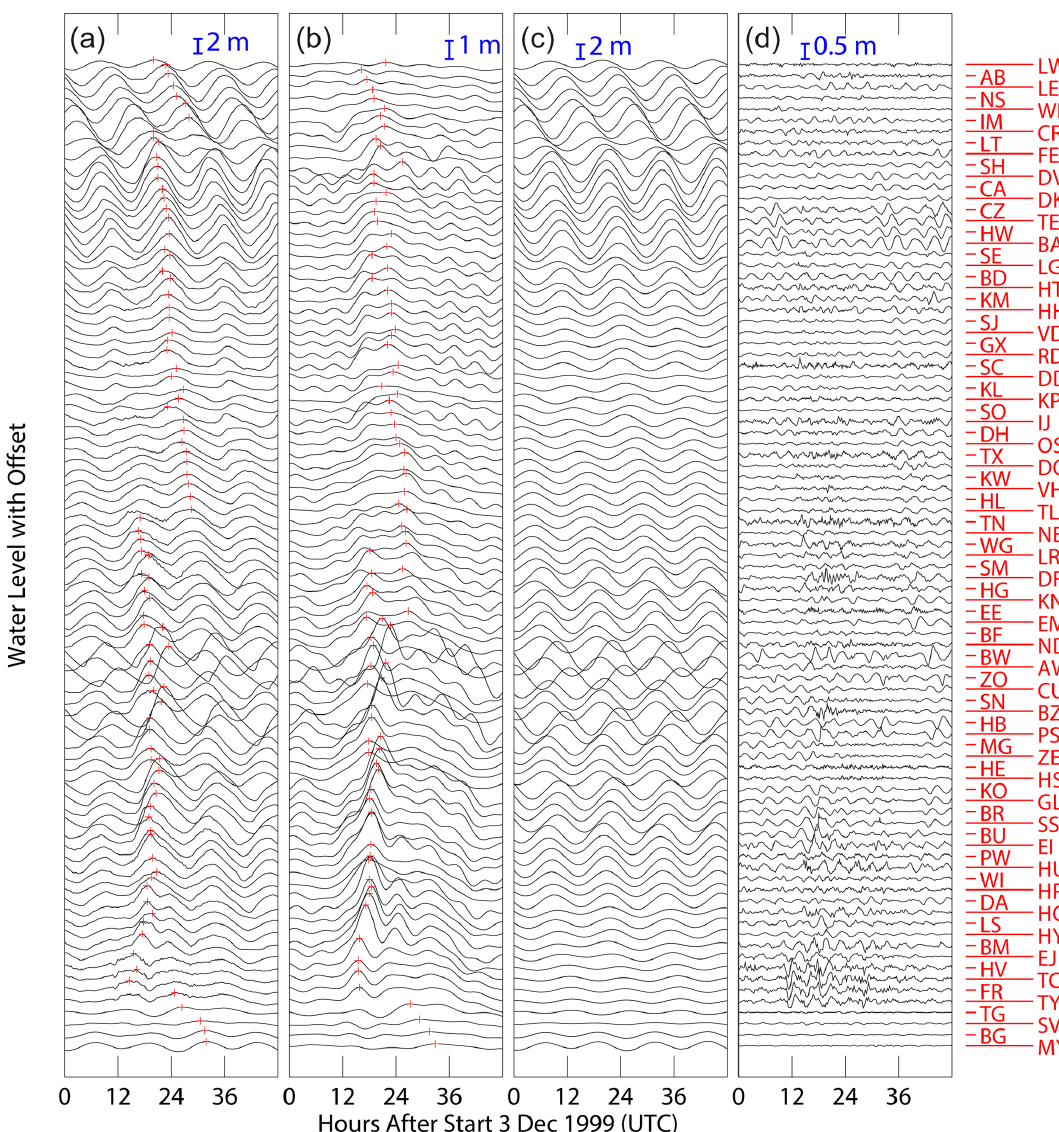
Figure 5. Time series of the (a) original water level data, and reconstructions of the (b) long period, (c) diurnal plus semi-diurnal tide, and (d) short period components of the original time series. The station identifications are given by two letter codes along the right hand side of the last panel. The stations have been vertically offset according to their relative arrangement counter-clockwise around the North Sea, starting from Lerwick in Scotland at the top and ending with Maløy in Norway at the